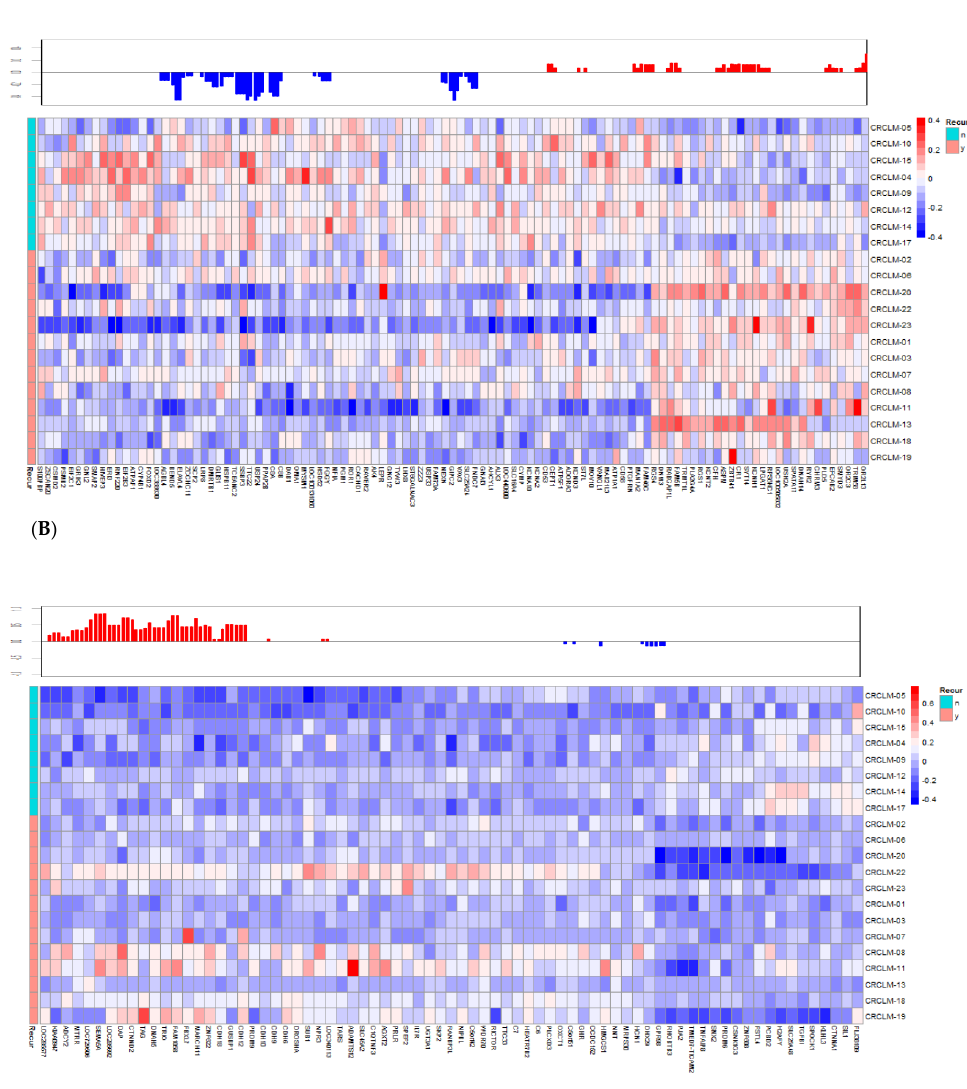
Figure 4. ( A ) The recurrence-associated region on chromosome 1. ( B ) The recurrence-associated region on chromosome 5.